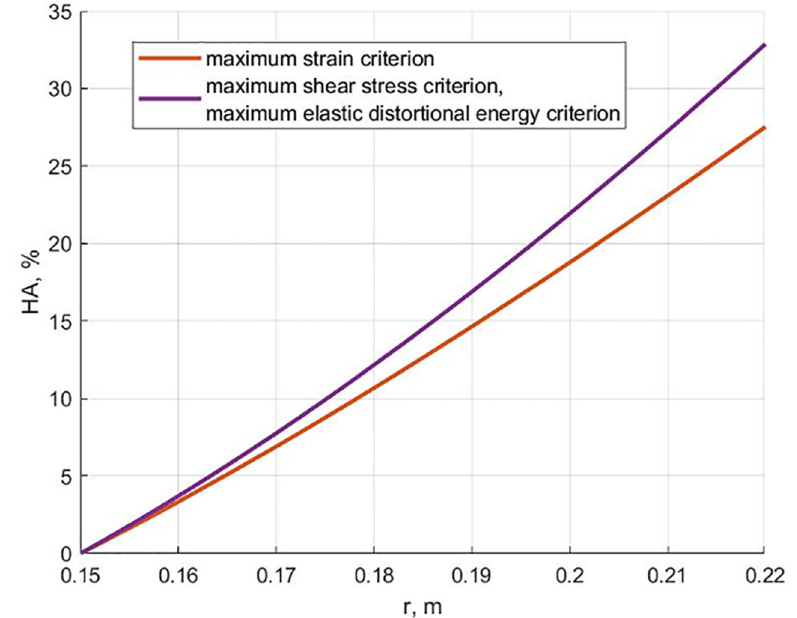
Figure 11. Content of hydroxyapatite depending on the radius for equally stressed cylinders at the end of the creep process according to various cylinder theories.